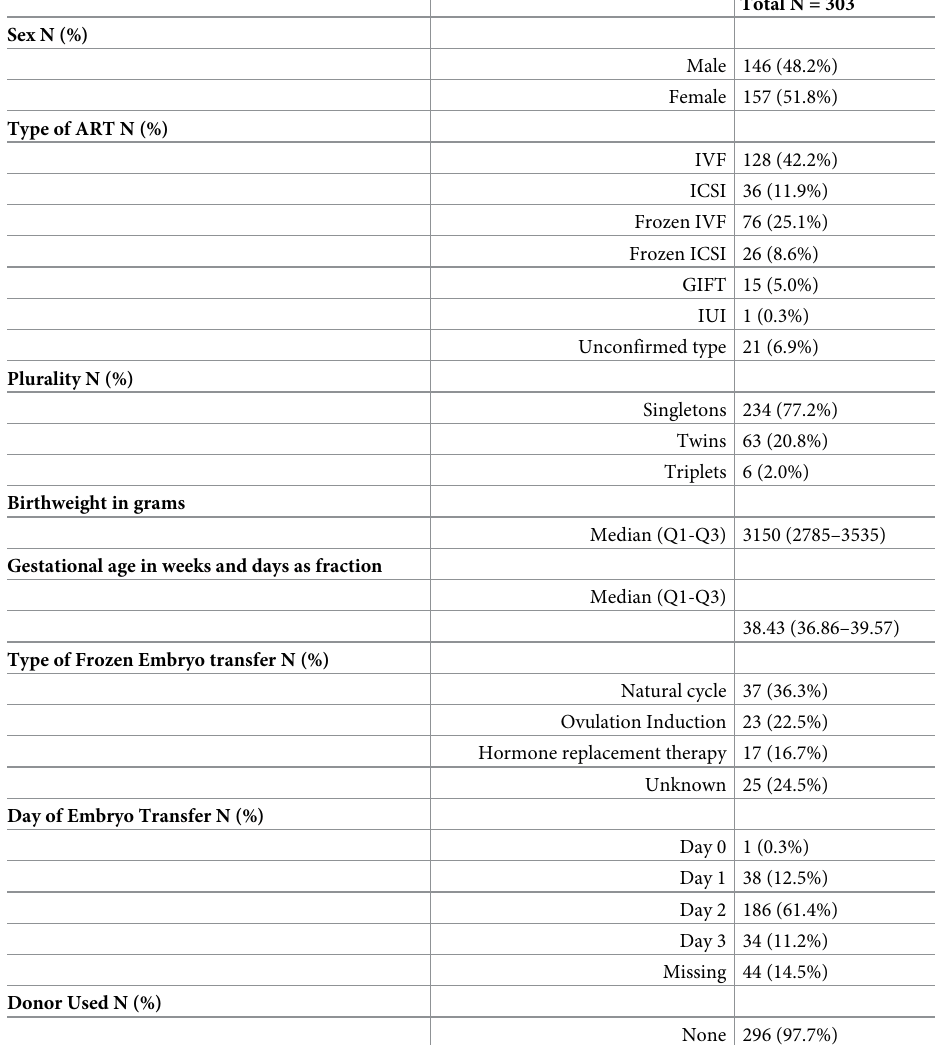
Table 2. Clinical characteristics of the GUHS